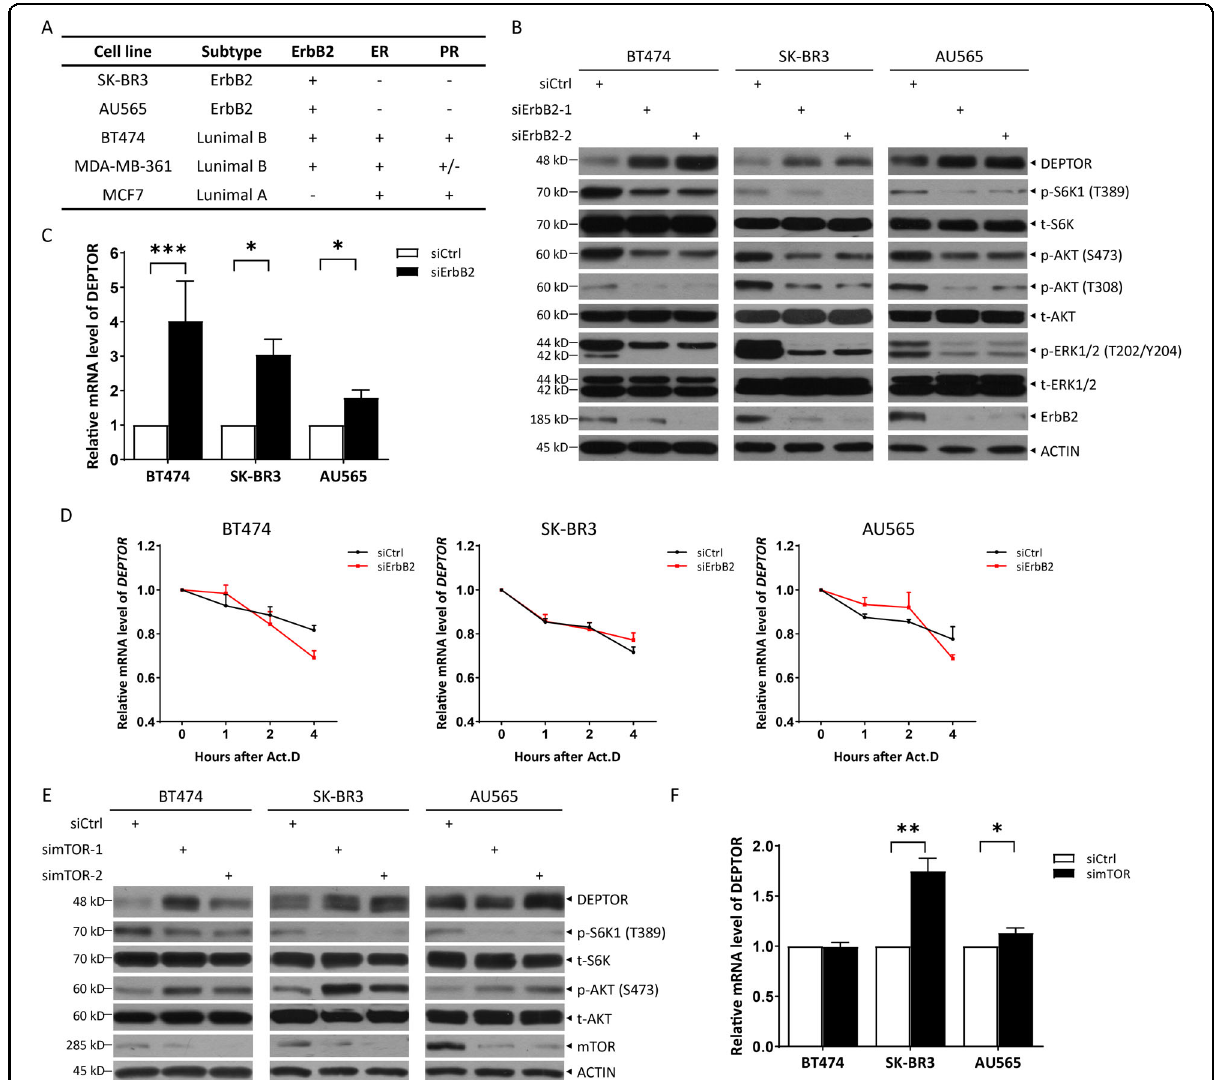
Fig. 1 DEPTOR is negatively regulated by ErbB2 at transcription levels. A The molecular characteristics of breast cancer cells. B – D ErbB2 knockdown signi fi cantly induced the expression of DEPTOR at transcriptional levels: BT474, SK-BR3, and AU565 cells were transfected with siRNA targeting ErbB2 or scrambled control siRNA, and then subjected to western blotting ( B ) or qRT-PCR analysis ( C , n = 3); or treated with 5 μ g/ml of actinomycin D (Act. D) for indicated time periods, and then subjected to qRT-PCR analysis ( D , n = 3). E , F mTOR silencing moderately increased the expression of DEPTOR: BT474, SK-BR3, and AU565 cells were transfected with siRNA targeting mTOR or scrambled control siRNA, and then subjected to western blotting ( E ) or qRT-PCR analysis ( F , n = 3). Data from three independent experiments were expressed as mean ± SEM, * p < 0.05, ** p < 0.01, *** p <